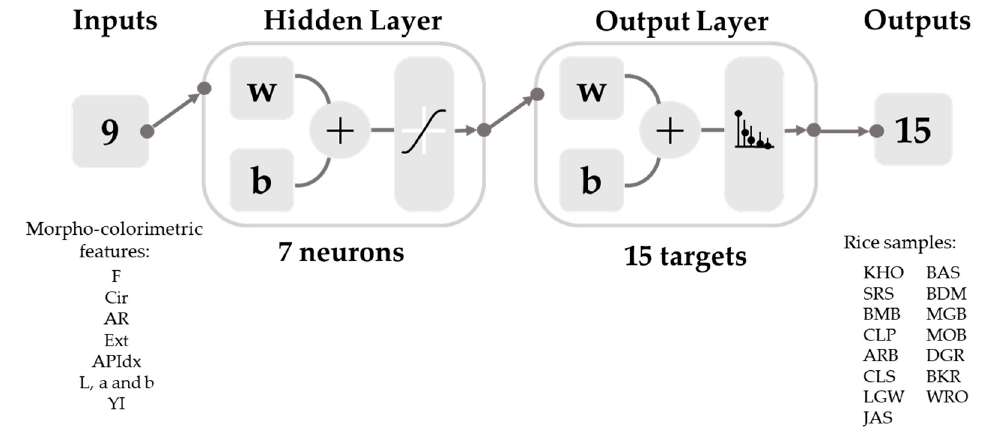
Figure 4. Diagram of a neural network model (Model 1) of the Bayesian Regularization algorithm with seven hidden neurons and sigmoid function showing nine inputs of morpho-colorimetric parameters and 15 outputs of commercial rice grains. The abbreviations for the morpho-colorimetric parameters ( inputs ) and commercial rice grains ( outputs ) are shown in Tables 1 and 2. w = weight; b = bias.